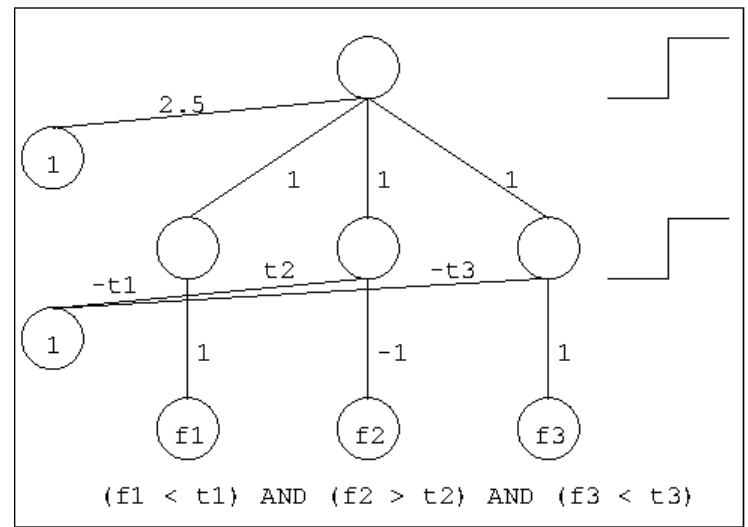
Figure 3. Coding of a propositional rule with three antecedents. The first layer of weights specifies the antecedents, while the second layer achieves the logical “and” of the antecedents. The activation function of the neurons is a step